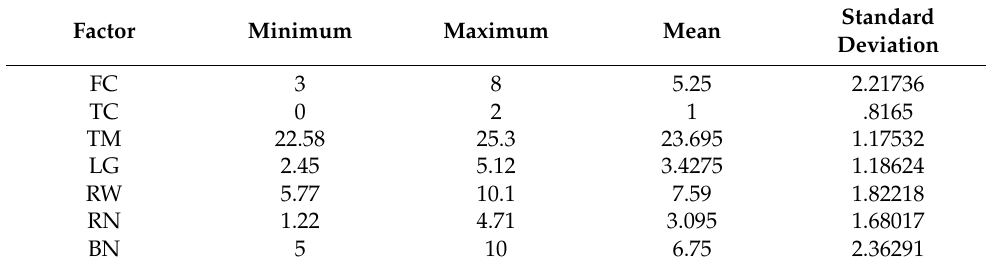
Table 2. Descriptive statistics of original